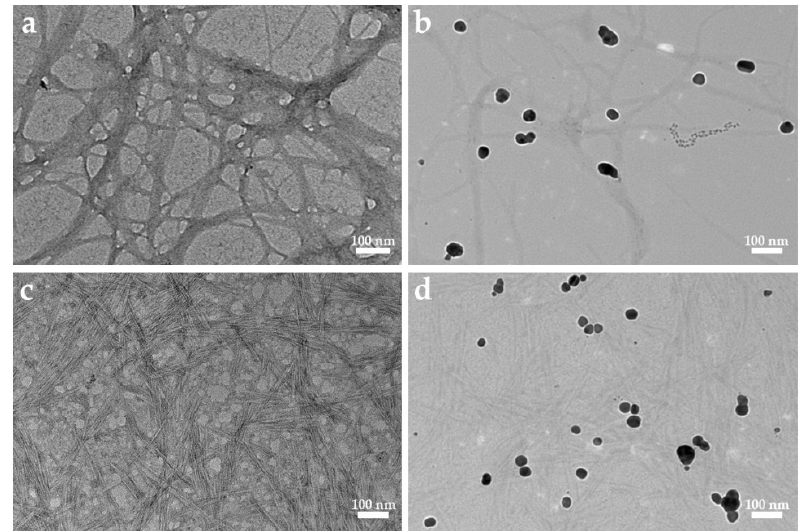
Figure 2. TEM images of the samples. ( a ) CNF, ( b ) CNF-AgNPs, ( c ) CNC, ( d ) CNC-AgNPs.